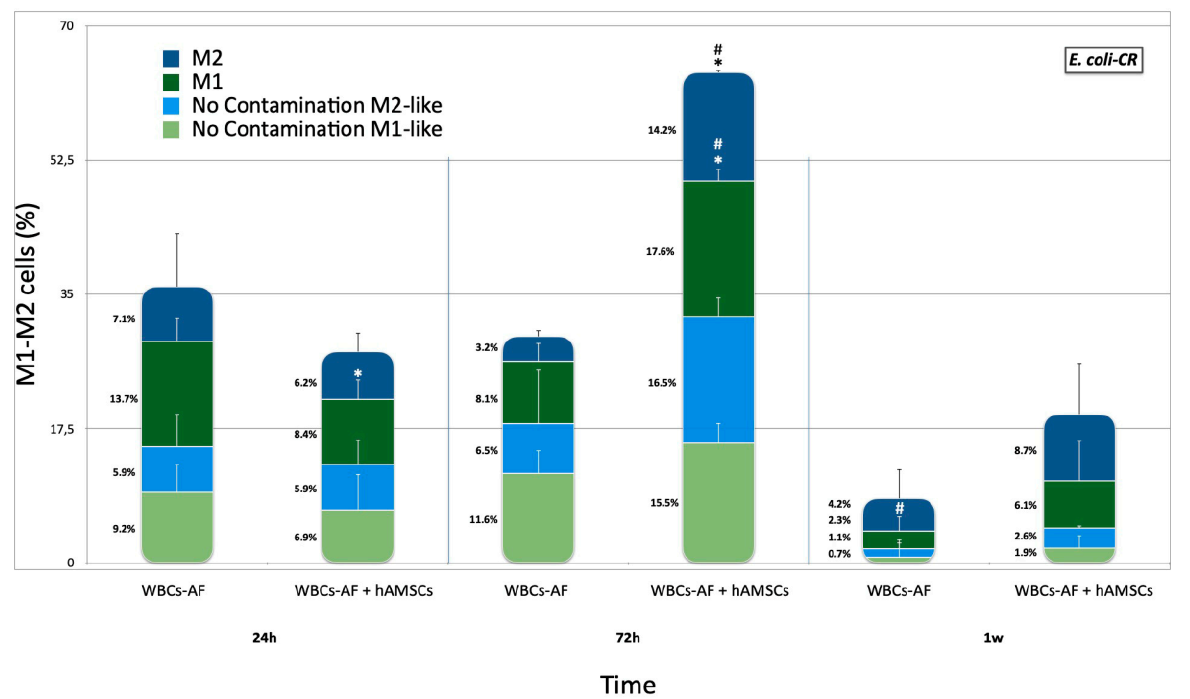
Figure 4. M1 and M2 phenotypes expressed by WBCs derived from the ascites of cirrhotic patients infected with E. coli-CR , after co-culture, with and without hA-MSCs, for the time points chosen (1 h, 24 h, 72 h, and 1 week) compared to the M1 and M2 phenotypes expressed by WBCs cultured without E. coli-CR infection. The macrophage polarization was influenced after 72 h in the presence of hA-MSCs. In particular, at 24 h, there was a reduction in M1 macrophage ( p < 0.05, *) in the presence of hA-MSCs compared to M1 macrophage grown without hA-MSCs under the same conditions but, at 72 h, the presence of MSCs showed a significant increase in both M1-like and M2-like components compared to the same culture conditions, both at 24 h ( p < 0.05, #) and at the same time in the absence of MSC ( p < 0.05, *). At 1 week, a significant reduction in M1 macrophage population was found compared to 24 h ( p < 0.05, #), while there was no change in both M1 and M2 macrophage populations grown in co-culture with